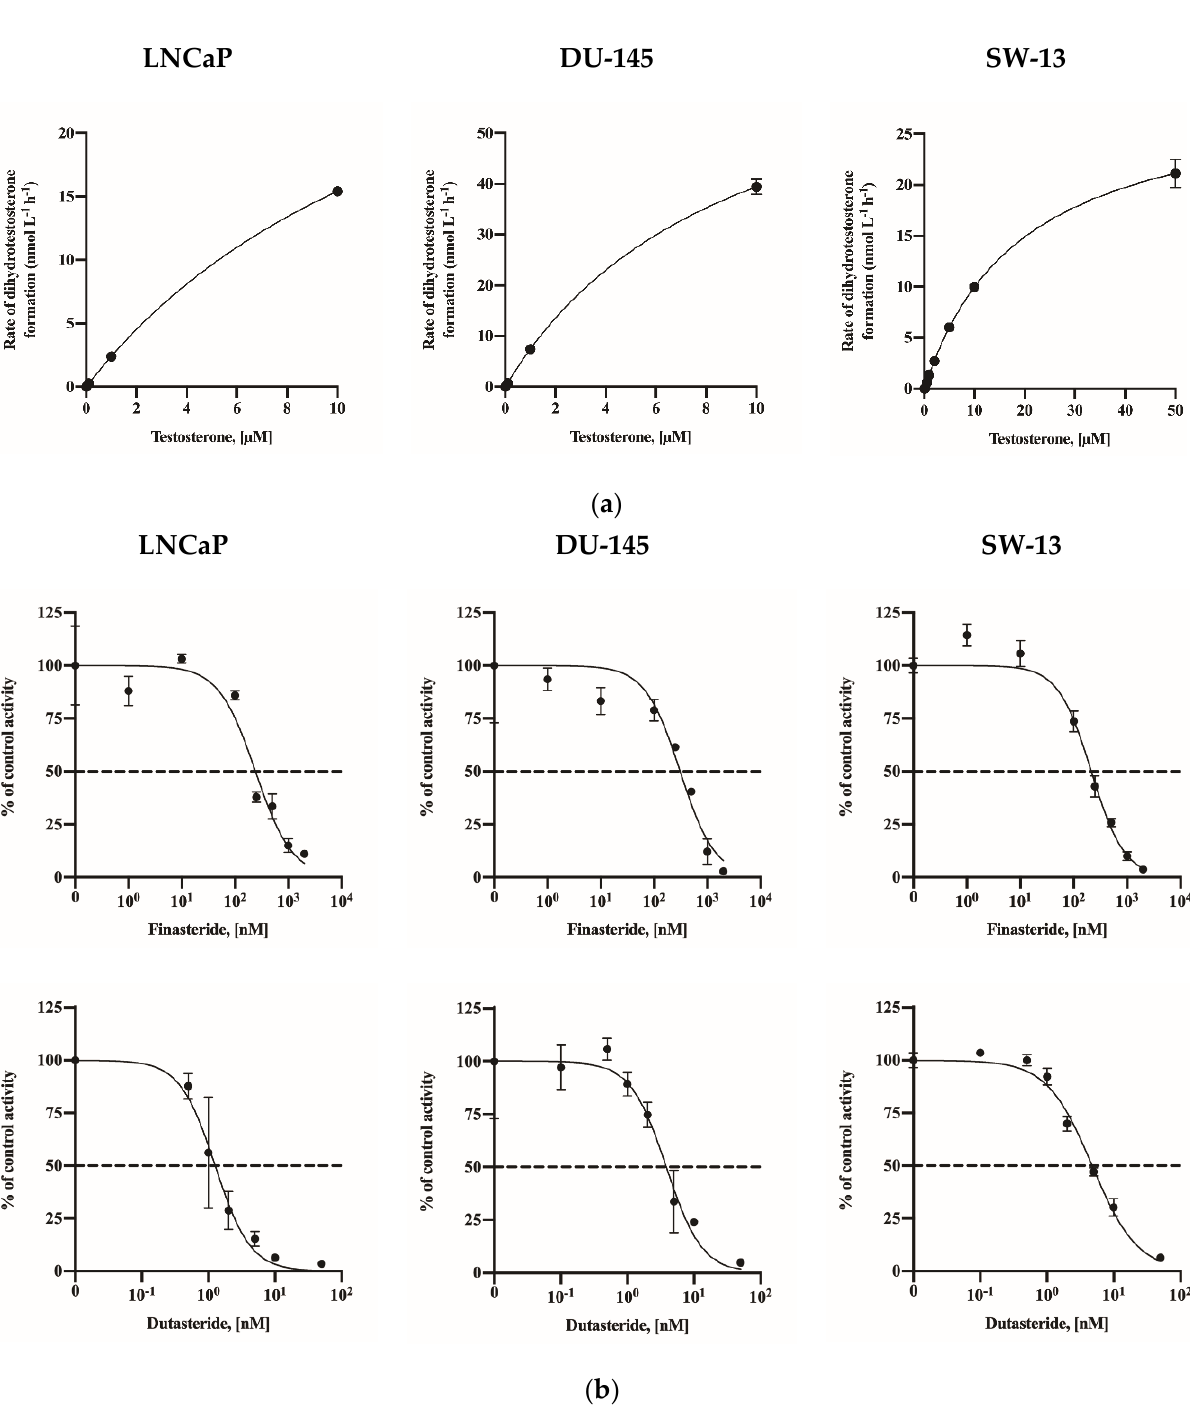
Figure 2. Quantitative PCR analysis for measuring the mRNA expression levels of SRD5A1 and SRD5A2 in the LNCaP, DU-145, and SW-13 cell lines. The data are expressed as the mean ± stand- ard deviation (SD) of three repeated experiments.